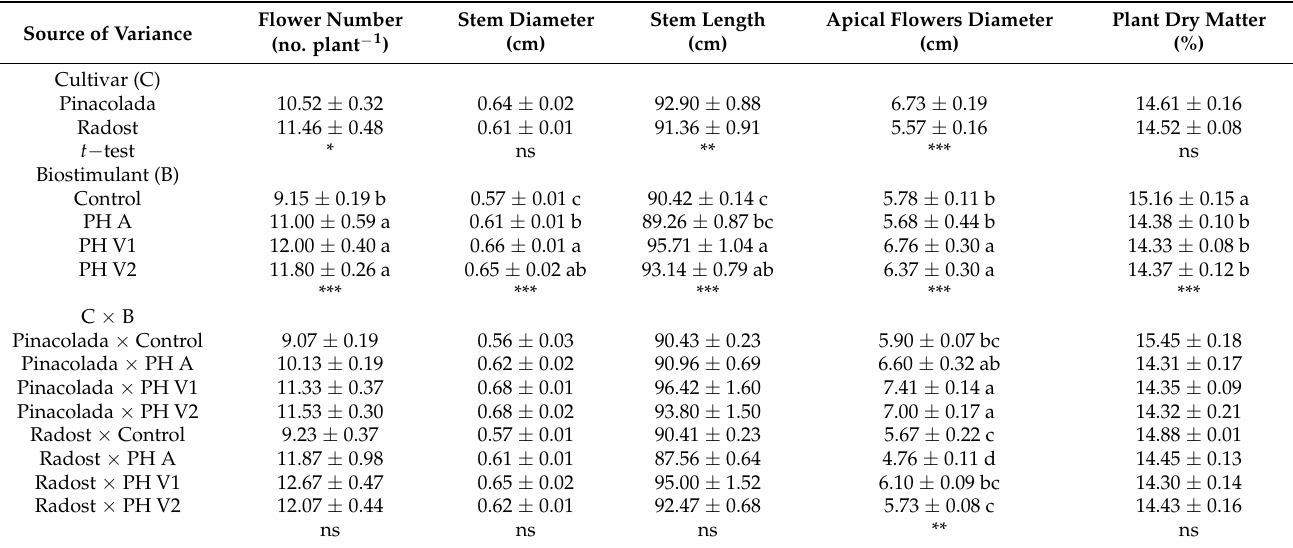
Table 1. The effect of biostimulant treatments (untreated control, one animal PH (PH A, Hicure ® ), or two vegetal PHs (PH V1, Trainer ® and PH V2, Vegamin ® )) on ornamental quality parameters of two chrysanthemum cultivars (Pinacolada and Radost) grown under greenhouse conditions. All data are expressed as mean ± standard error; n =